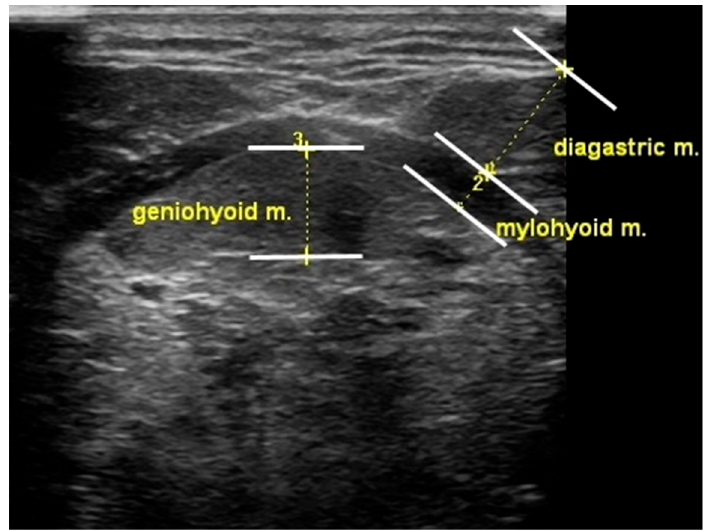
Figure 2. Measurement of oropharyngeal muscle thickness.